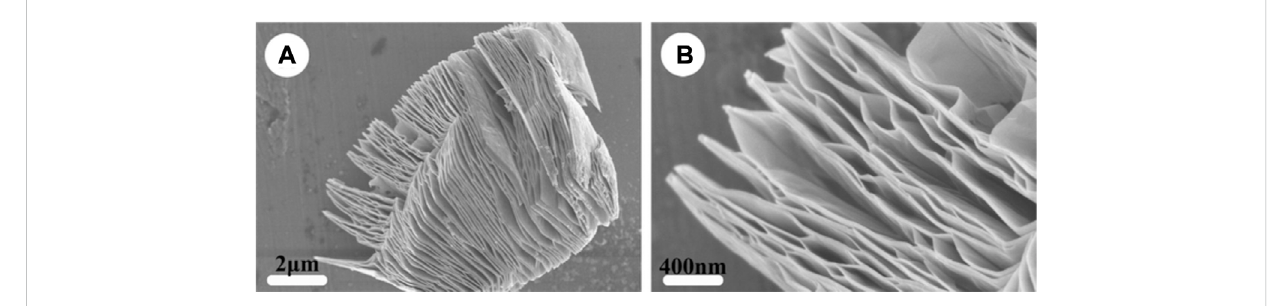
Structure of MXene. SEM images of (A) MXene-Ti3C2 and (B) the high-magni fi cation of (A) . (Wang et al.,